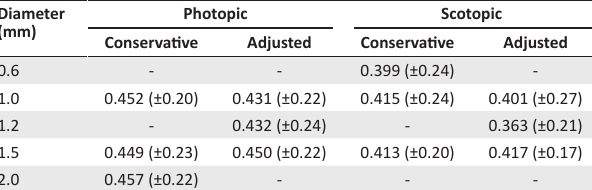
TABLE 6: Summary of results obtained for the three pinhole diameters that gave the best fractional difference minimum angle of resolution improvements for all subjects.